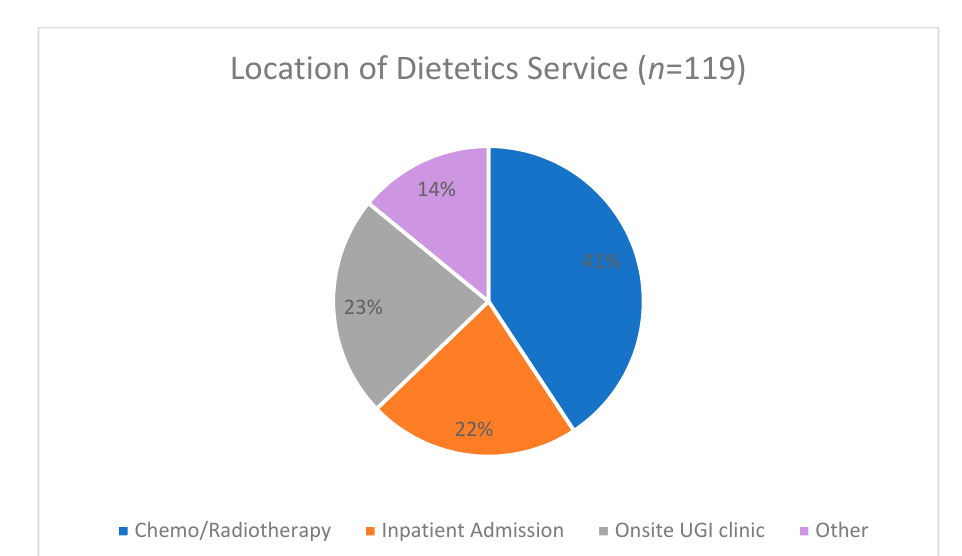
Figure 1. Location of dietetics service ( n = 119). UGI, upper gastrointestinal.